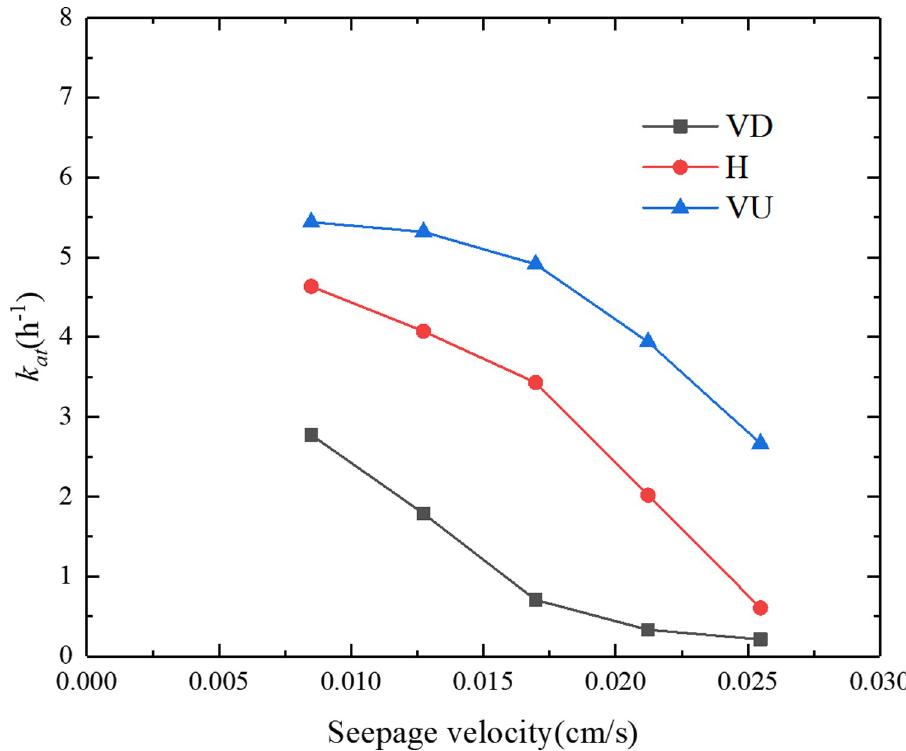
Fig 9. Relationship between the particle deposition rate and the seepage velocity under the three different seepage